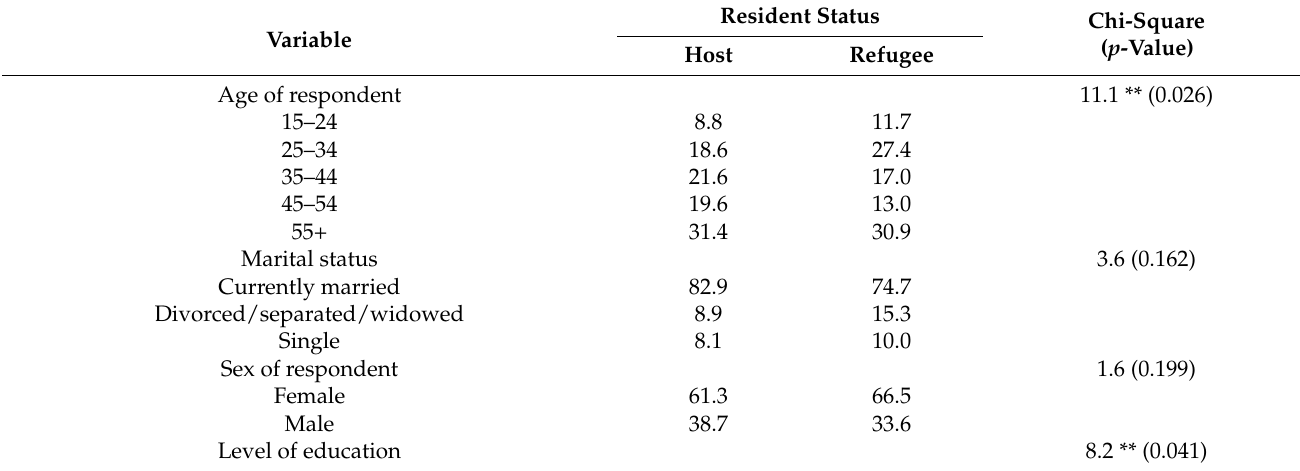
Table 2. Distribution of respondents by resident